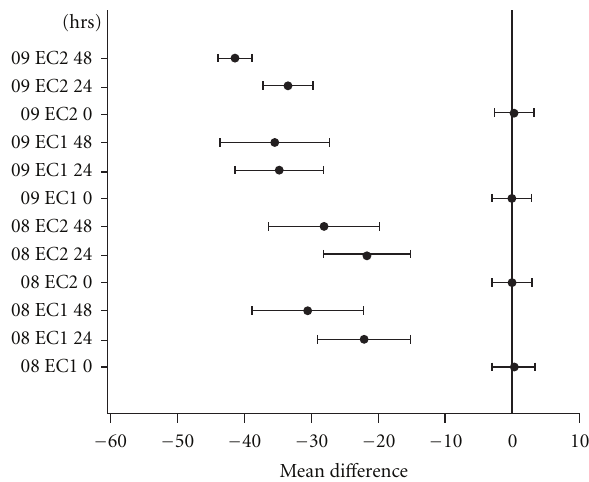
Figure 2: A collection of 95% confidence intervals for the di ff erence in mean motility between 24-hour and 48-hour observations.